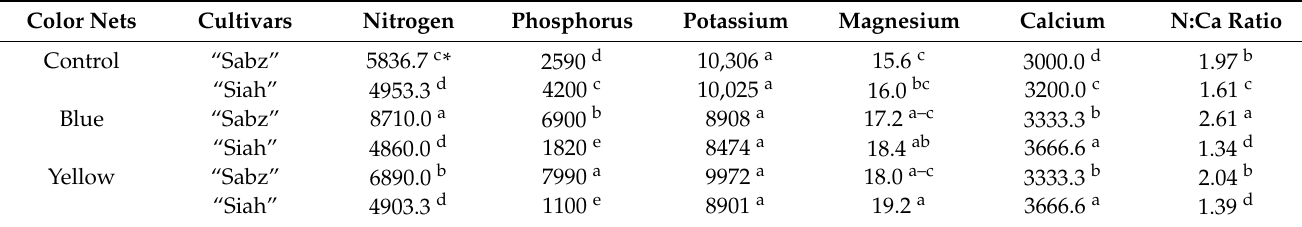
Table 2. The combined effects of color nets and fig cultivars on mineral elements in the dried figs (ppm.). Color Nets Cultivars Nitrogen Control